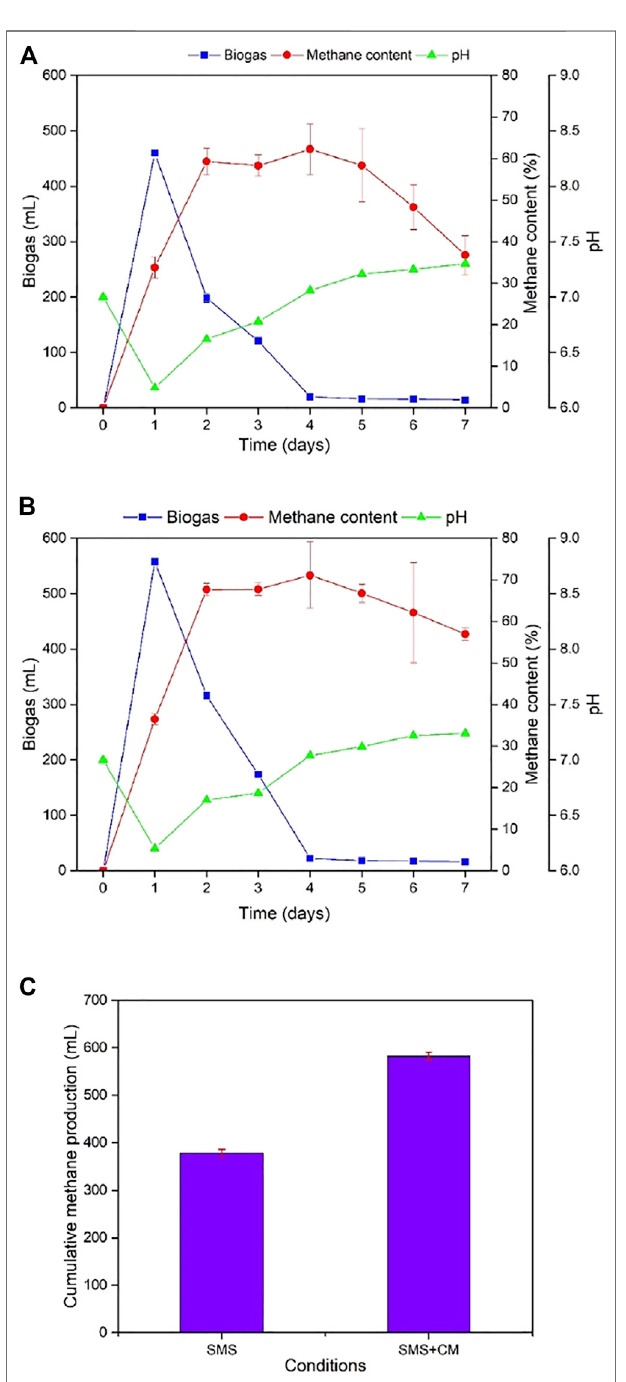
FIGURE 1 | Daily biogas production, methane content, and pH for (A) monodigestion and (B) co-digestion. (C) Cumulative methane production for the monodigestion and co-digestion